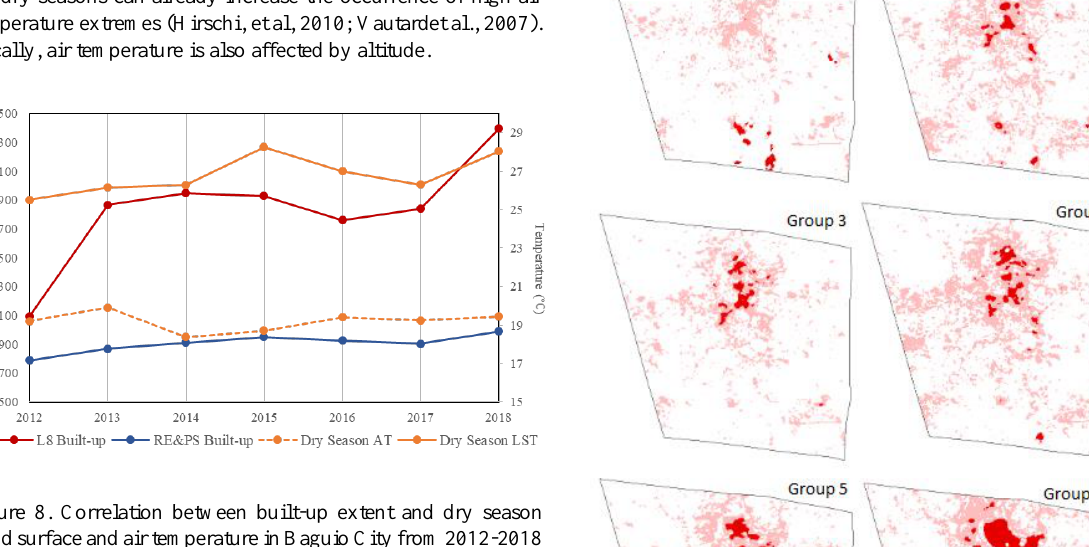
Figure 8. Correlation between built-up extent and dry season Land surface and air temperature in Baguio City from 2012-2018